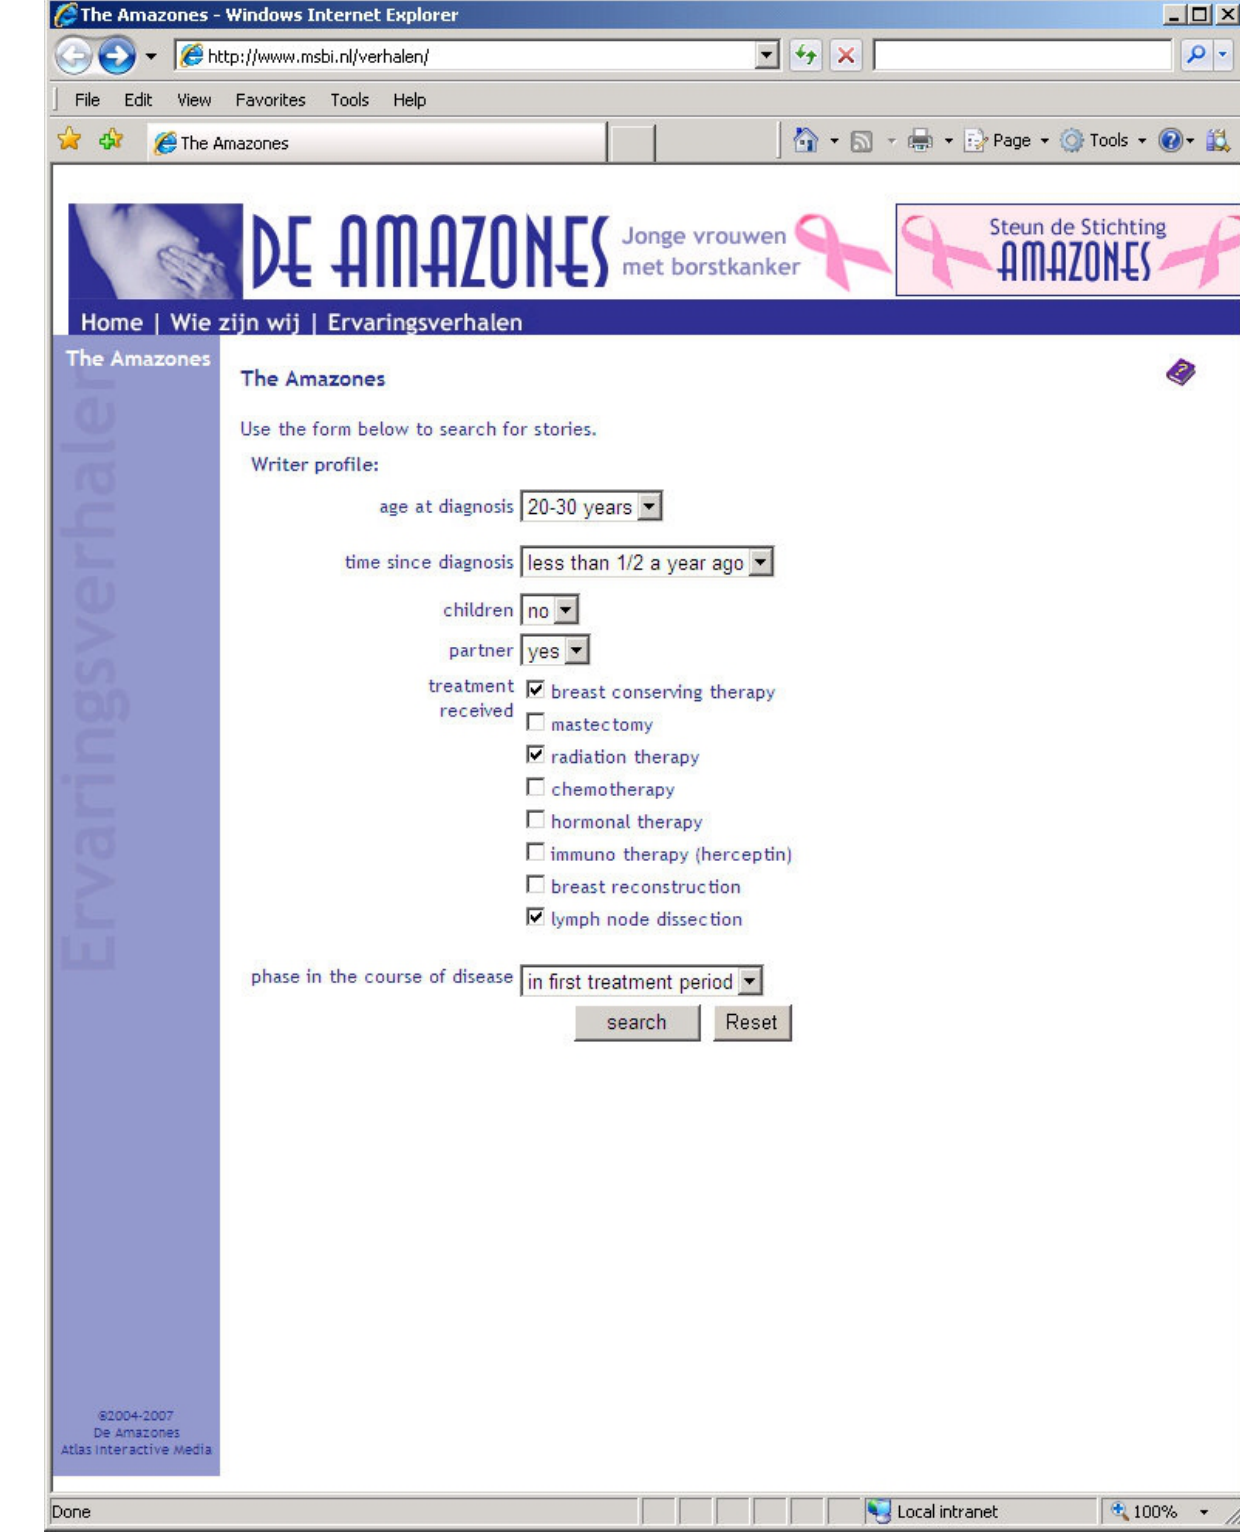
Figure 3. Screenshot of the writer profile group search